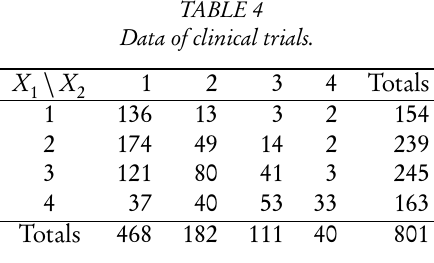
Data of clinical